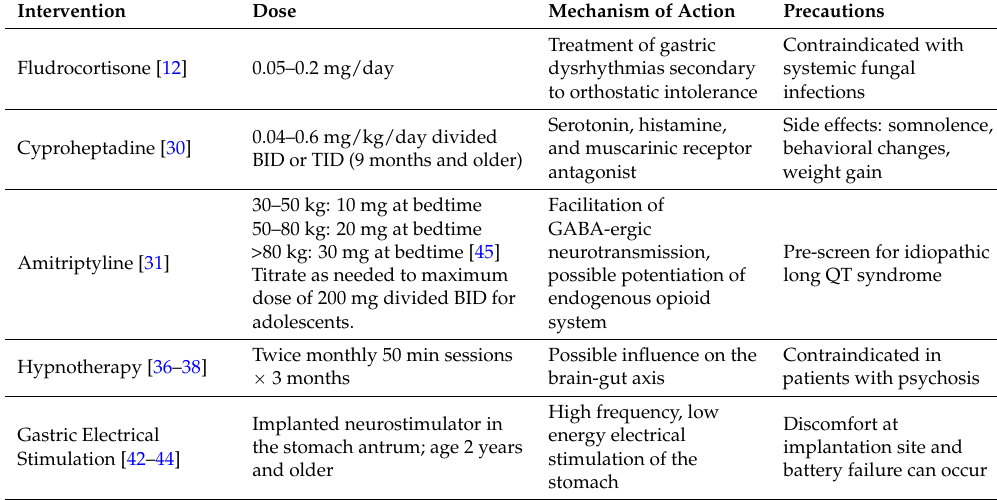
Table 1. Summary of treatments for pediatric chronic functional nausea with pediatric